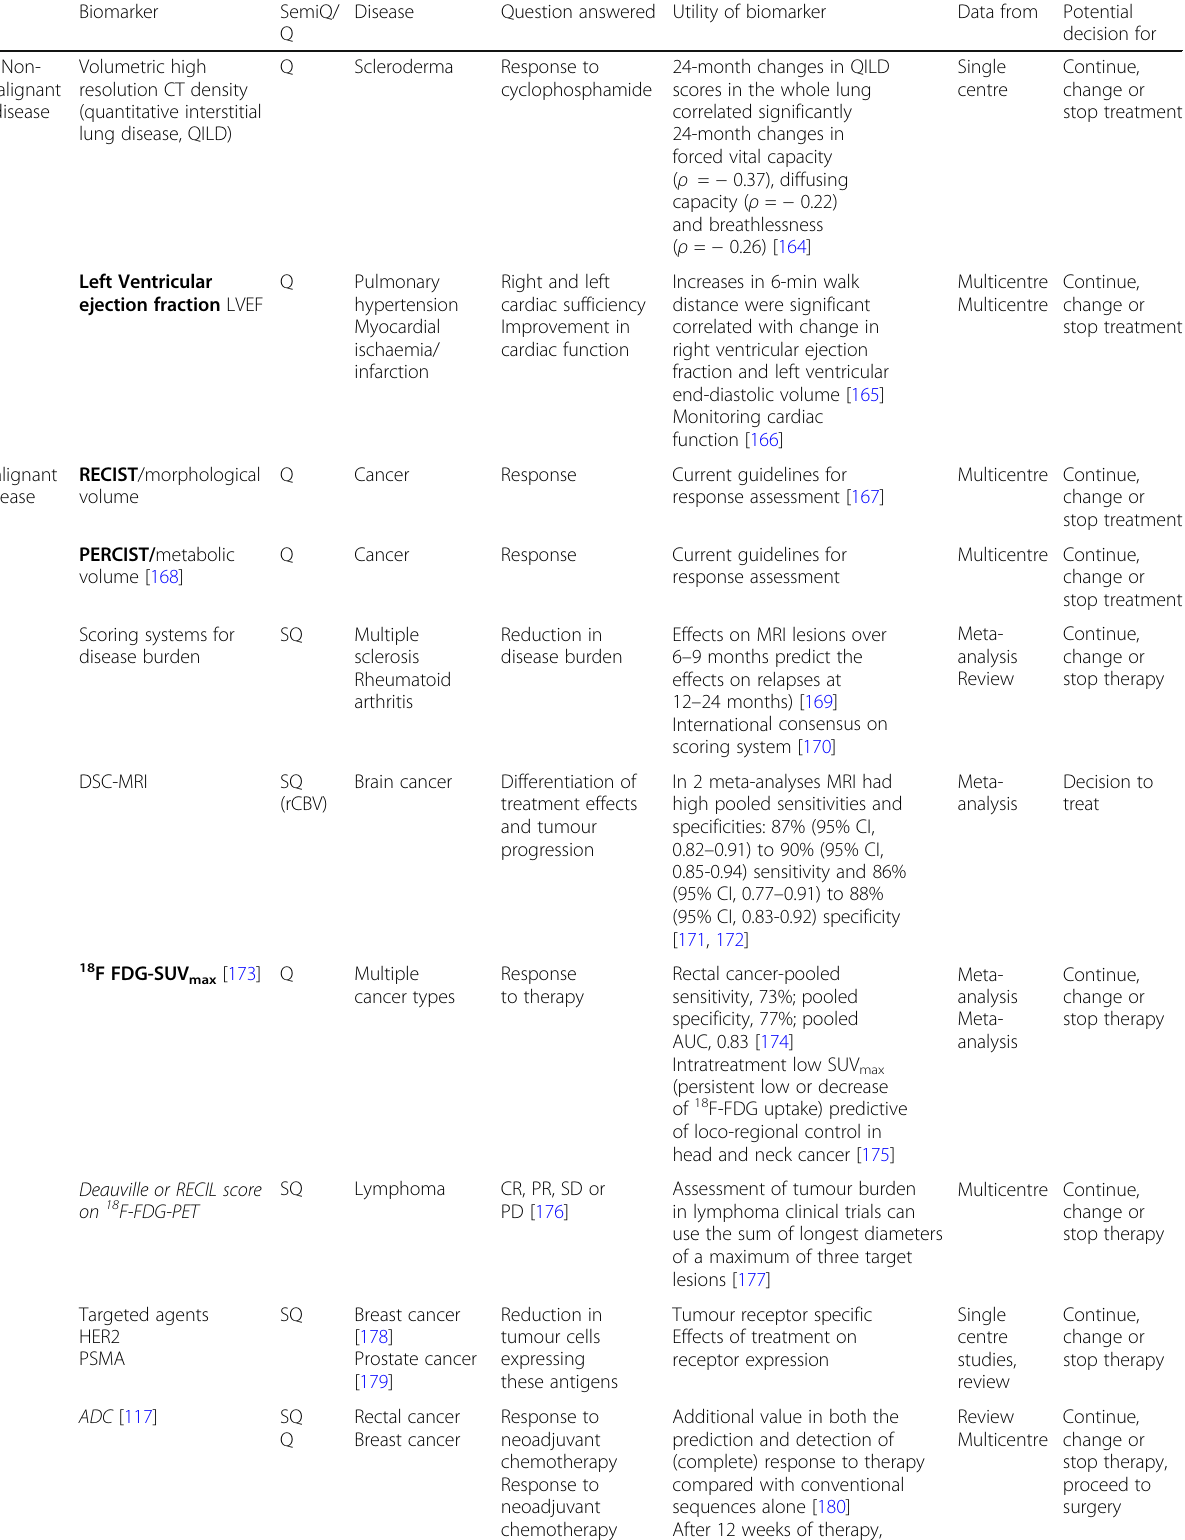
Table 3 Imaging biomarkers for disease response assessment (semi-quantitative and quantitative) with examples of current evidence for their use that would support